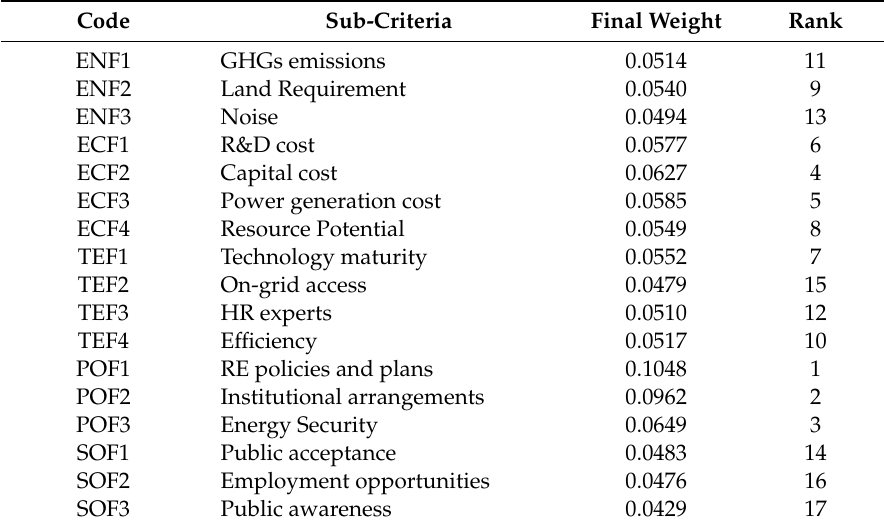
Table 8. Ranking of overall